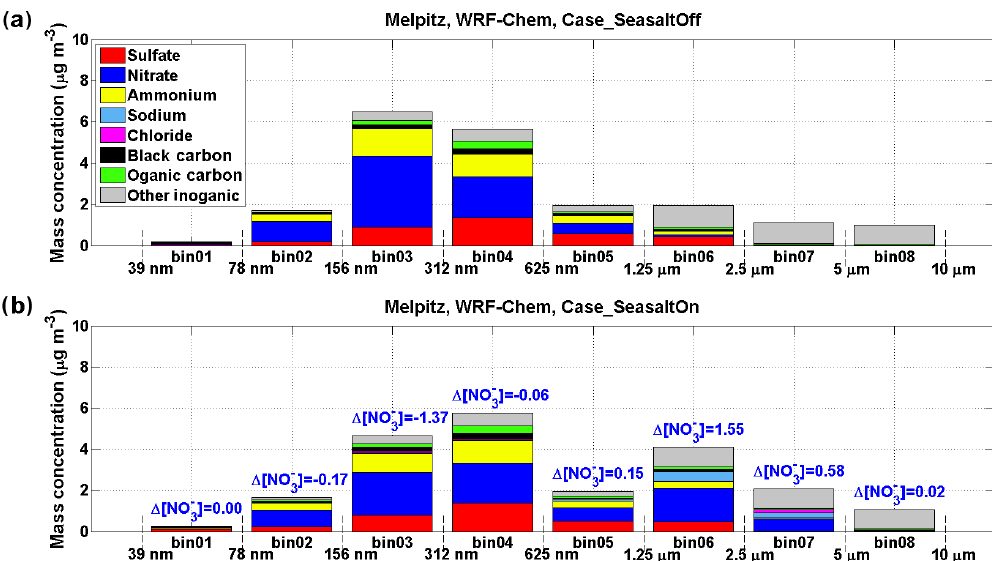
Figure 2. Model results of mass concentration of each chemical compound in eight size bins at Melpitz. The results shown here are averaged during 17 September 2013 when marine air masses started approaching Melpitz. Sodium is used as an indicator of sea-salt aerosol. (a) Result of the “Case_SeasaltOff” simulation (without sea-salt emission). (b) Result of the “Case_SeasaltOn” simulation (with sea-salt emission). The differences between particulate nitrate mass concentration ( (cid:49) [NO − ]) in each size bin are marked. 3